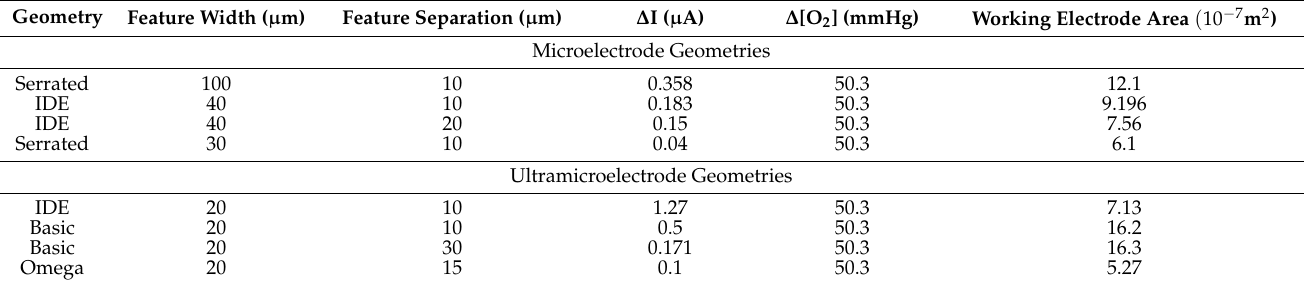
Table 1. Current responses of the microelectrode and ultramicroelectrode geometries. Geometry Feature Width ( µ